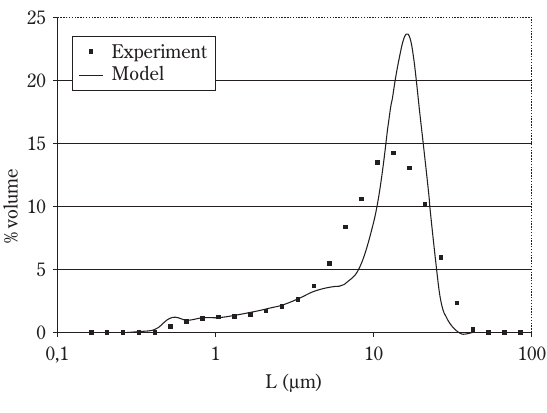
Fig. 5 Comparison of experimental and calculated PSD. Experimental conditions: T (cid:2) 180°C; N (cid:2) 2.92 s (cid:4) 1 ; stirrer power number (cid:2) 1; stirrer diameter (cid:2) 0.08 m; for other para- metric values see Table 5